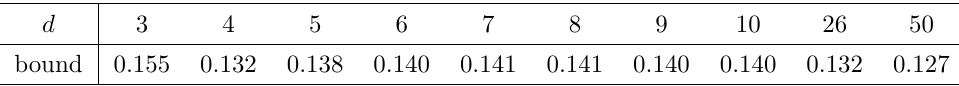
g 2 M d Γ( d 2) in various spacetime (4 π ) d 2 Γ( d )